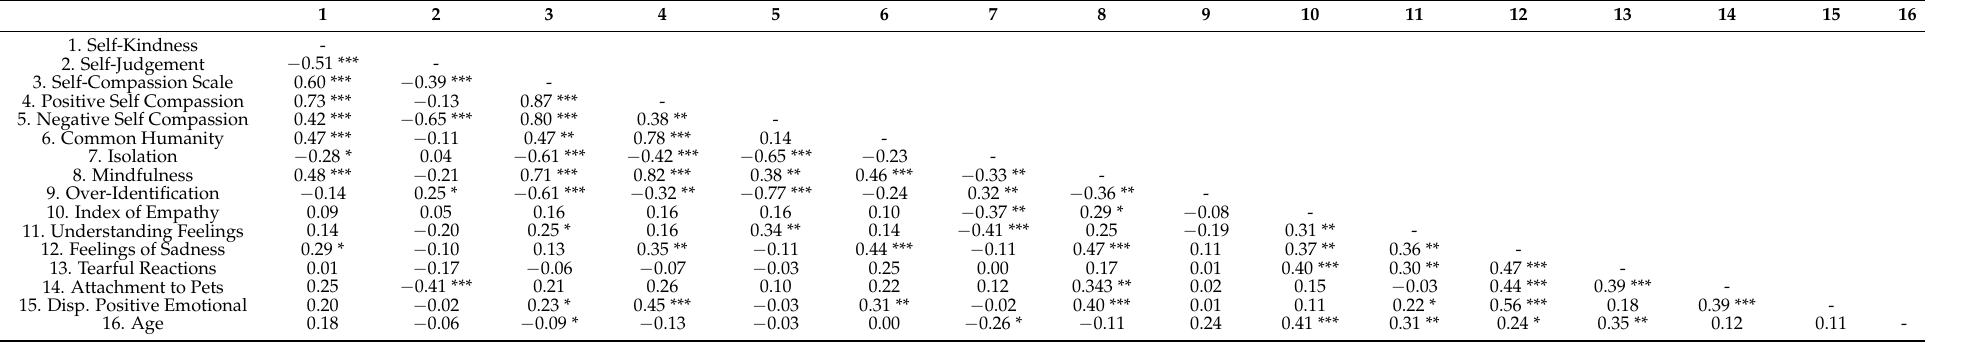
Table 2. Correlations among main test